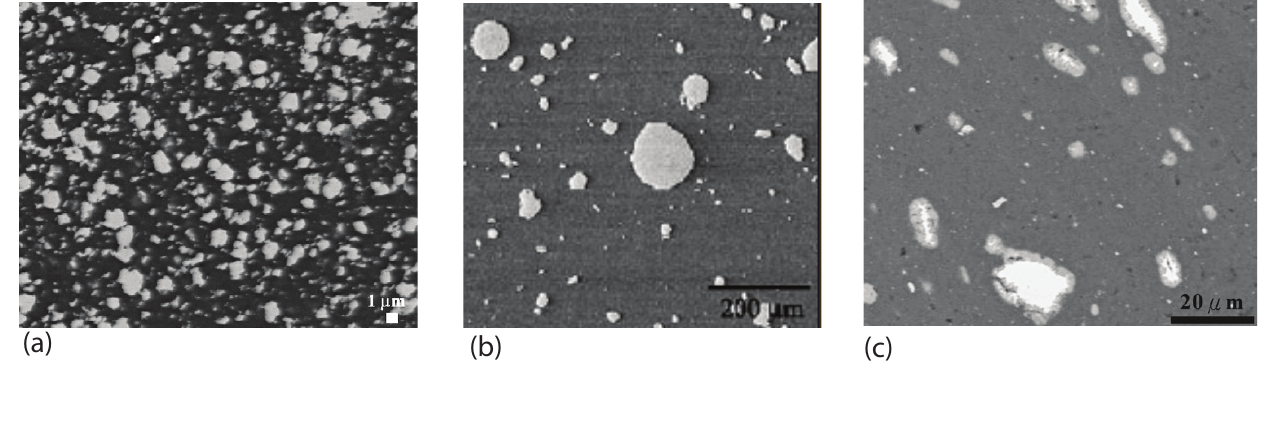
Cu particles (white contrast) 2 Fe particles in Al 3